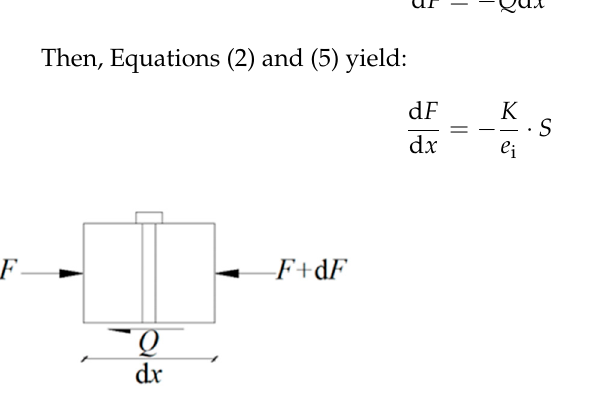
Figure 6. Equilibrium relation of timber–steel interface.